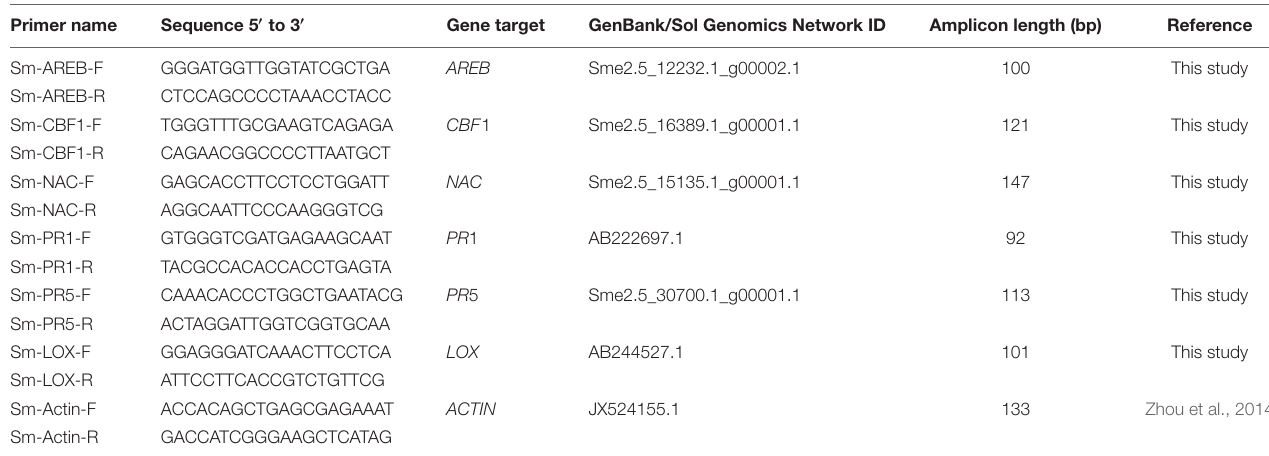
TABLE 1 | Primers sequences used for the gene expression